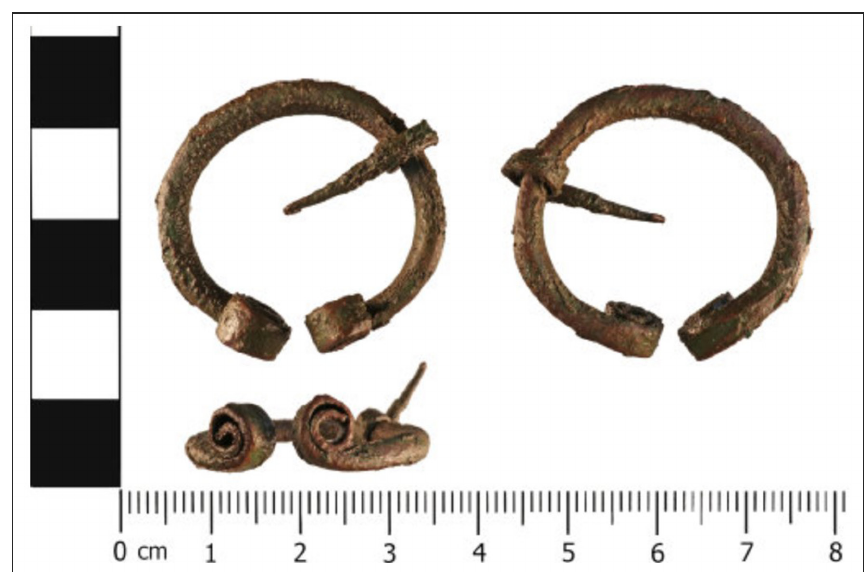
Figure 2: Copper alloys Penannular brooch found in Staffordshire (Image curtsey of the Portable Antiquities Scheme, Record ID: